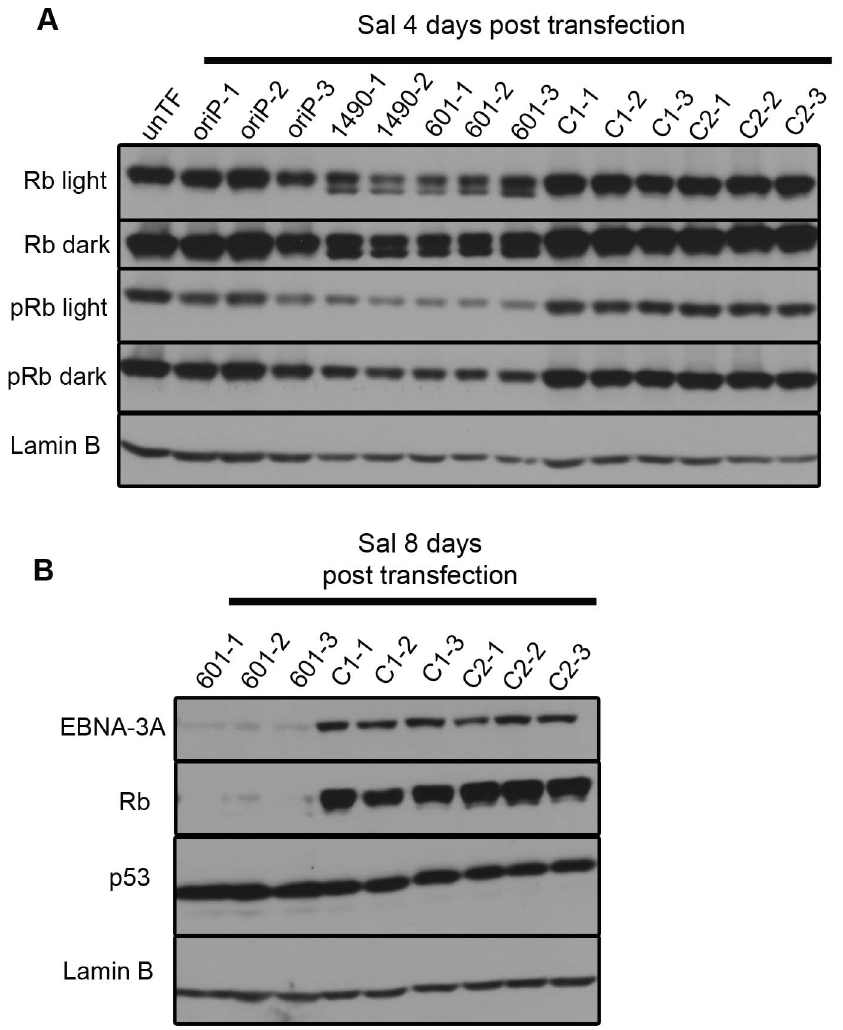
Figure 7. EBNA-3A supports maintenance of Rb hyperphosphorylation and stabilization in Wp-R latency. Immunoblots of transfected Sal cells harvested at (A) 4 days or (B) 8 days post-transfection were probed with a pan Rb antibody (Rb), a phospho-specific (pRb) antibody that recognizes the phosphorylated residues Ser807/811, and antibodies to detect p53 and Lamin B (loading control). Light and dark refer to film exposure